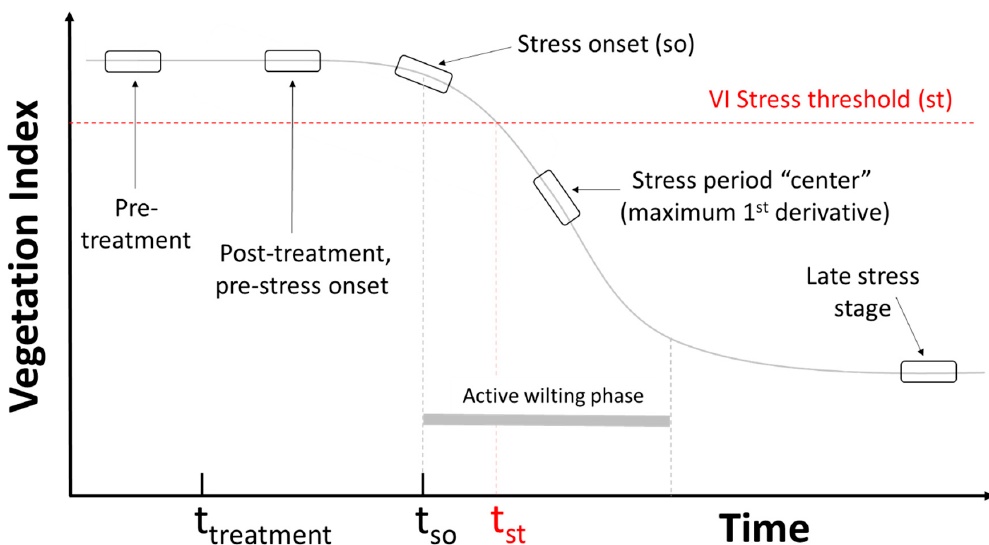
Figure 3. Idealized vegetation stress curve and important phases and transitions. Curve is for a VI that decreases in value with increasing stress, such as Normalized Difference Vegetation Index (NDVI). t treatment is the time of treatment, t so is stress onset (based on first inflection of VI curve), and t st is the time of crossing the VI stress threshold value. The horizontal bar signifies timing and duration of active wilting phase, beginning with stress onset (SO) inflection point. The vertical position of the horizontal bar is arbitrary.